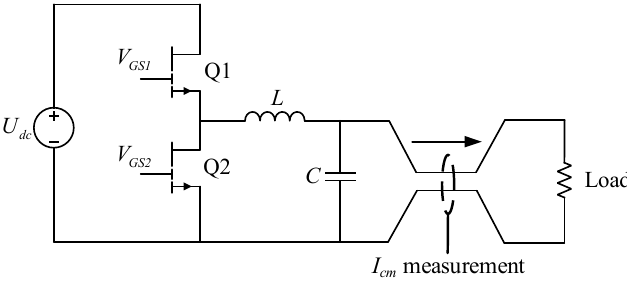
Figure 17. The common mode current measurement.